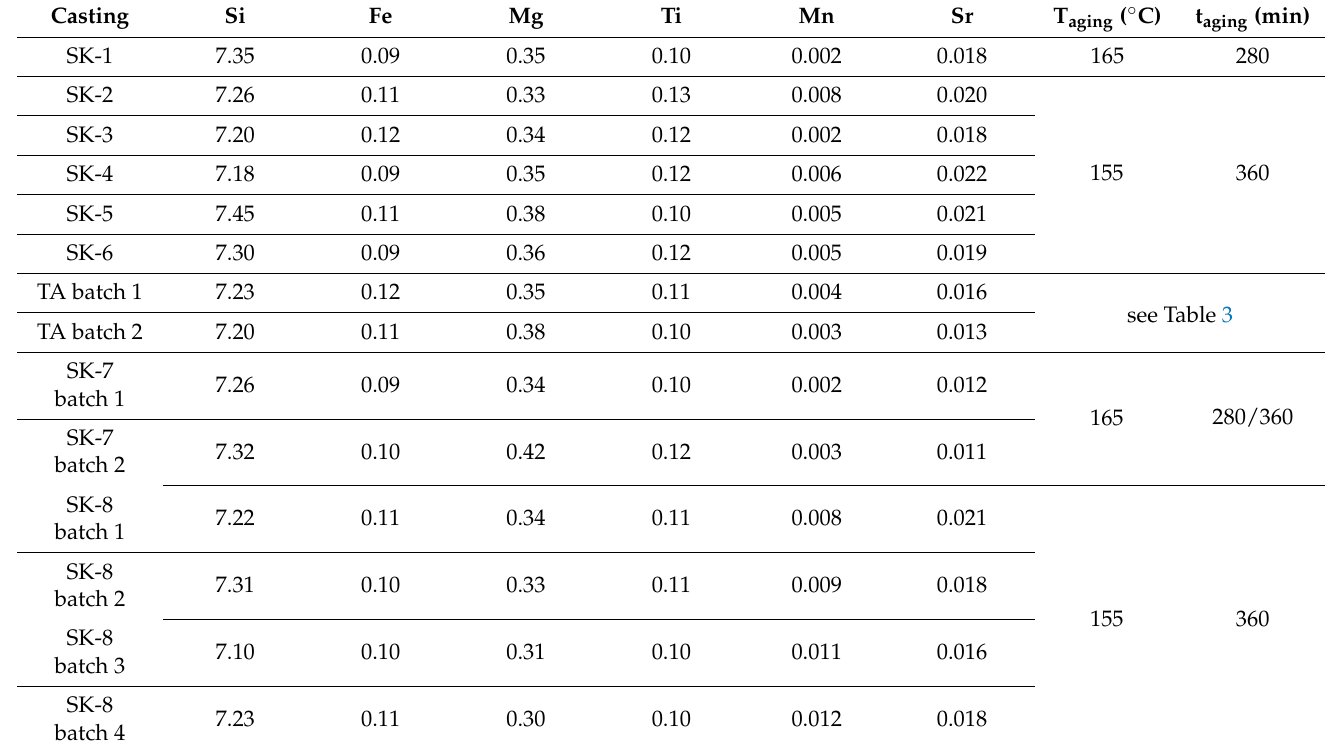
Table 2. Chemical composition of the melt batches prepared to manufacture the industrial castings (wt.%, Al balance) and aging parameters used in each case (to be complemented with Table 3).